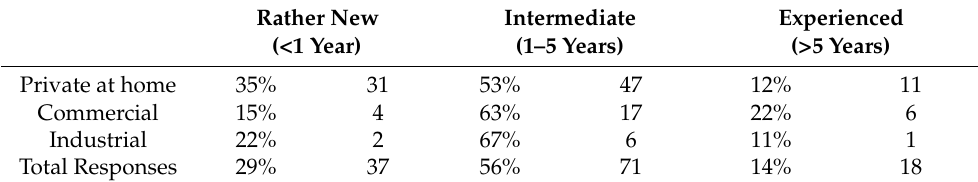
Table 1. Experience with the production of cold brew